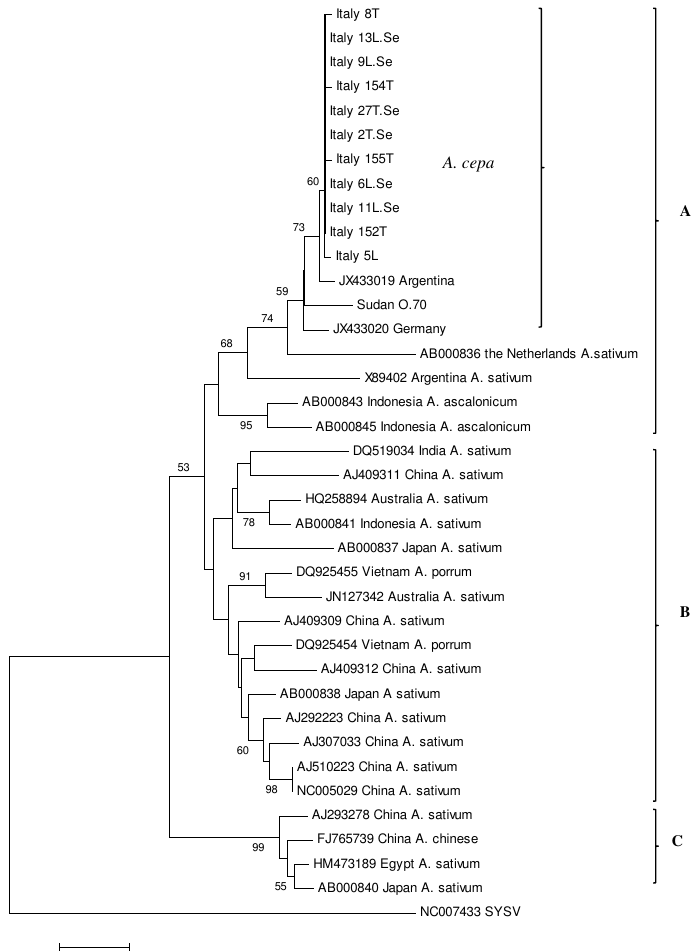
Figure 5. Neighbour-joining tree based on multiple alignment of 3’UTR sequences of OYDV between Italian and Sudanese isolates from this study, Argentine and German onion isolates and 23 Allium spp. isolates available from database. The sequence of SYSV (NC007433) was used as an out-group. Bootstrap percentages of clades, reported along the branches of the tree with value >50%, derived from bootstrap-resampled data sets (1000